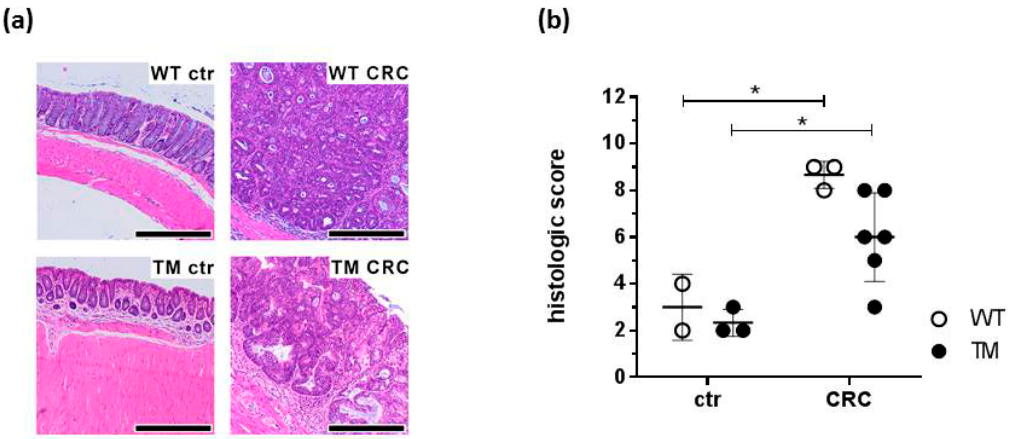
Figure 3. Colon tissues prepared out of the mice described in Figure 1 were fixed in buffered formalin, embedded in paraffin, and sliced into histological sections. Sections were stained with hematoxilin/eosin and evaluated for inflammation and tumor morphology. ( a ) Representative micro-photographs of the colon sections. ( b ) Quantitative grading of the tumors. WT: wild type, TM: H 4 R − / − , ctr: AOM-treated mice, CRC: AOM/DSS-treated mice. Magnification: 40×; scale bar: 300 µm. Individual values and means +/ − SD of n = 2–6. *, p < 0.05 (two-way ANOVA with Sidak’s post hoc